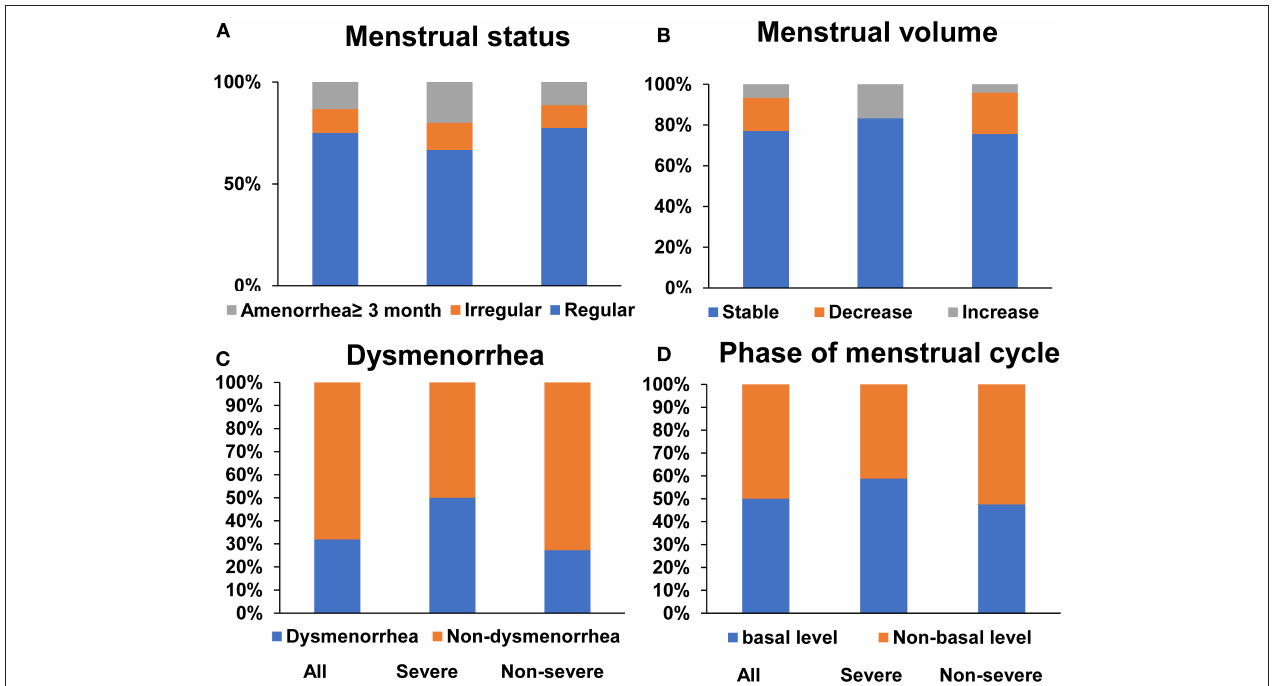
FIGURE 1 | Menstruation condition in COVID-19 reproductive-age women. Menstrual status (A) and menstrual volumes (B) in last 3 months, dysmenorrhea history (C) and phase of menstrual cycle (D) in all, severe and non-severe COVID women, respectively.